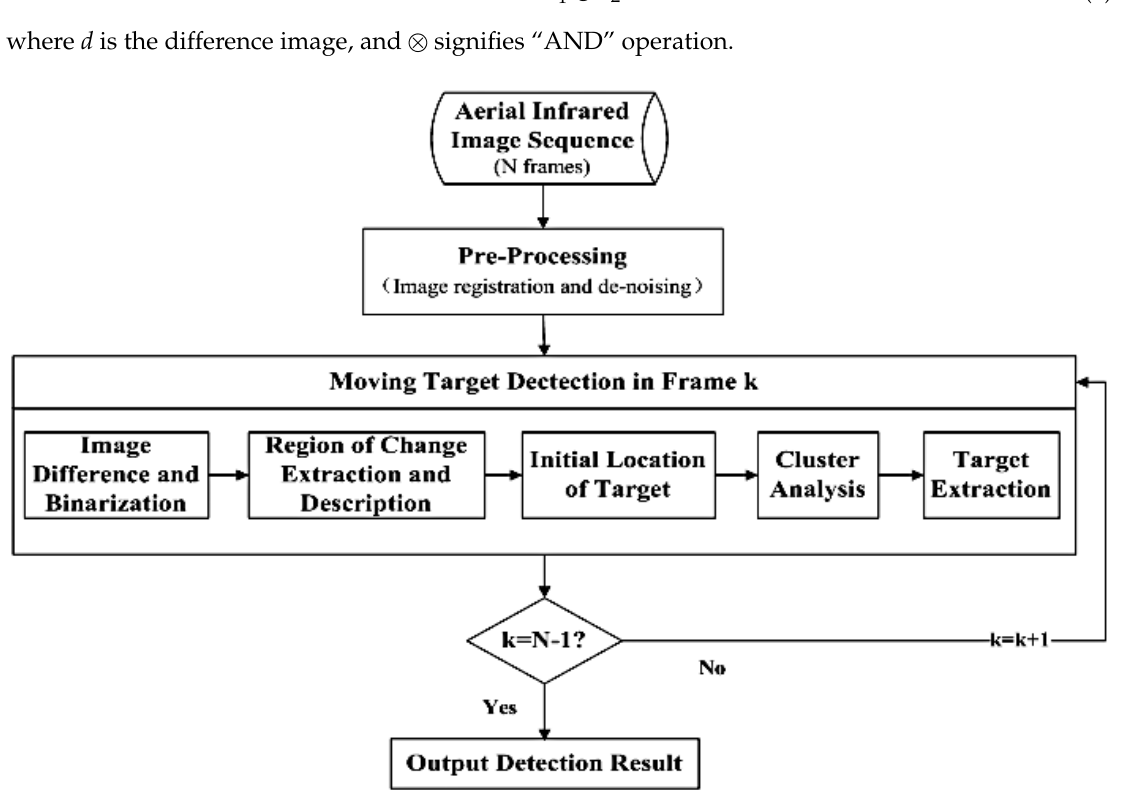
Figure 1. Flow chart of Symmetric Frame Differencing Target Detection Based on Local Clustering Segmentation (SFDLC) for target detection in aerial infrared image sequence.